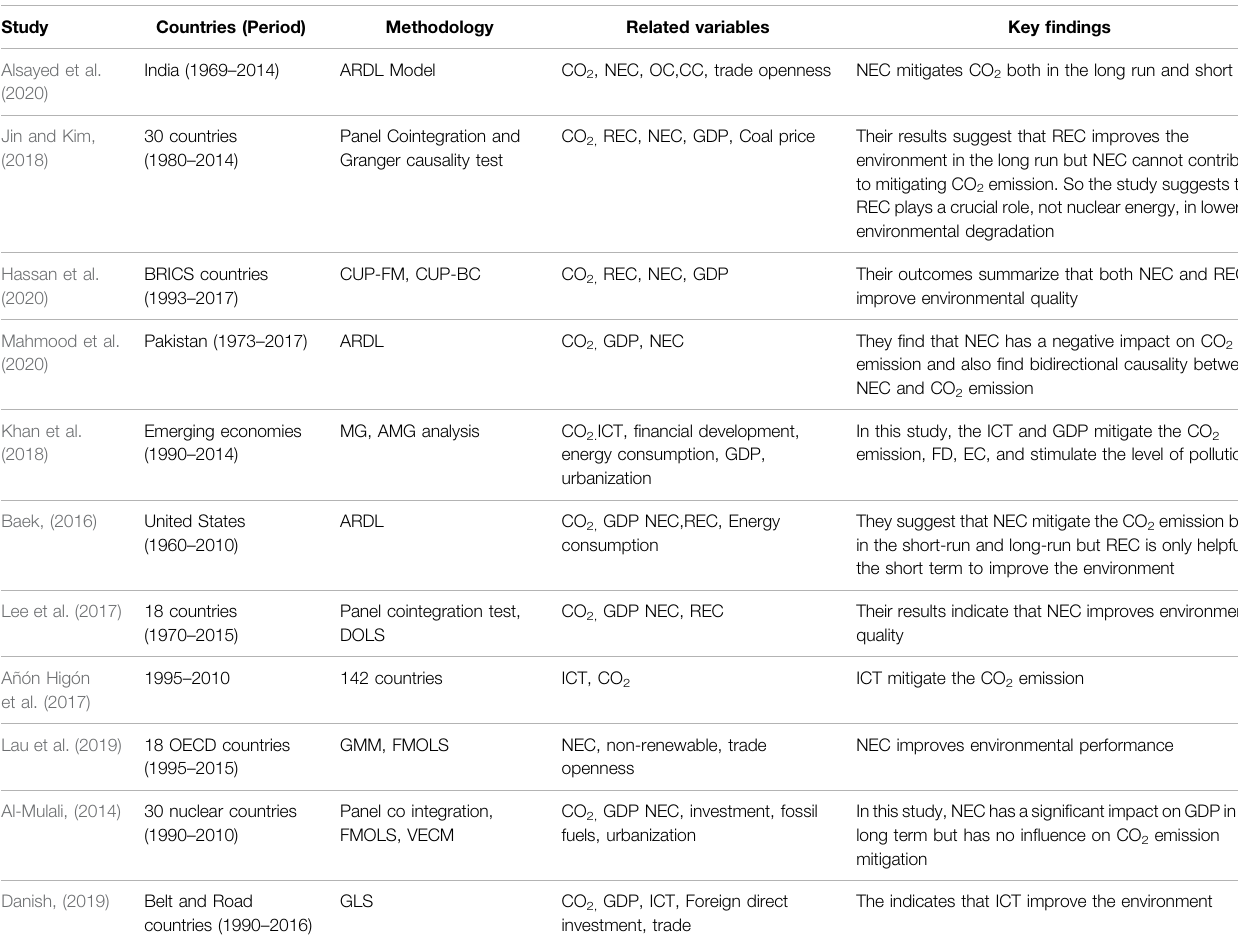
TABLE 1 | Summary of studies on the link between nuclear and renewable energy consumption- ICT on CO 2